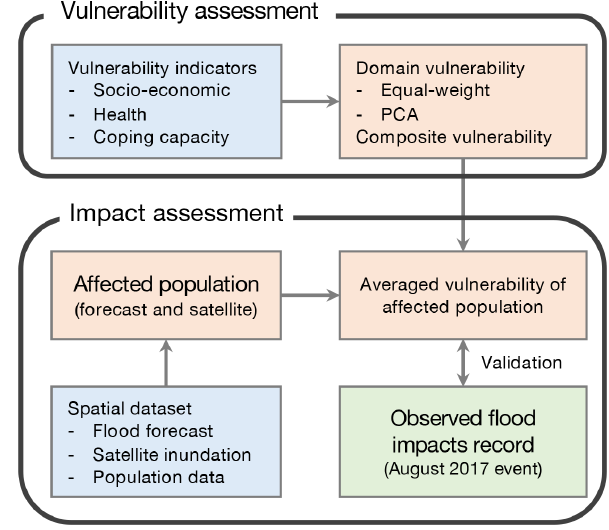
Figure 2. Vulnerability and impact assessment